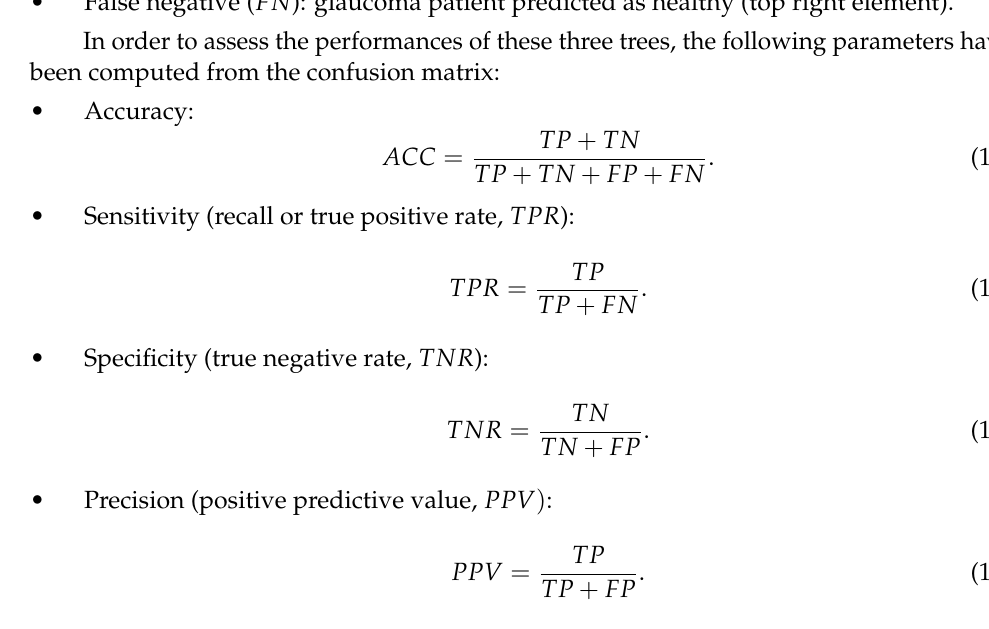
Table 5. Classification loss for observations not used for training ( w h = 1, w g =